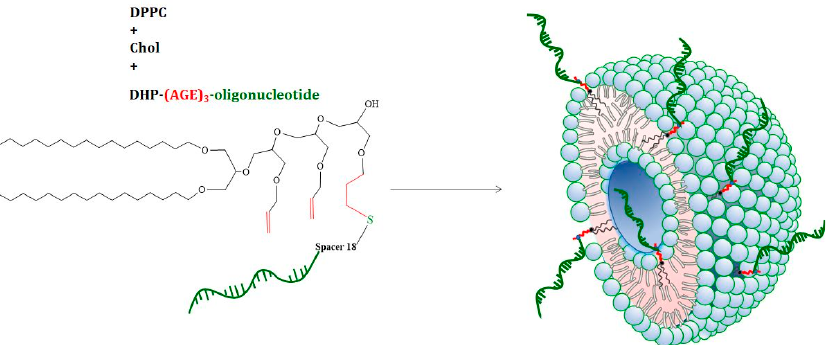
Figure 3. Schematics of the formation of vesicular SNAs from DPPC, cholesterol, and nucleolipid.